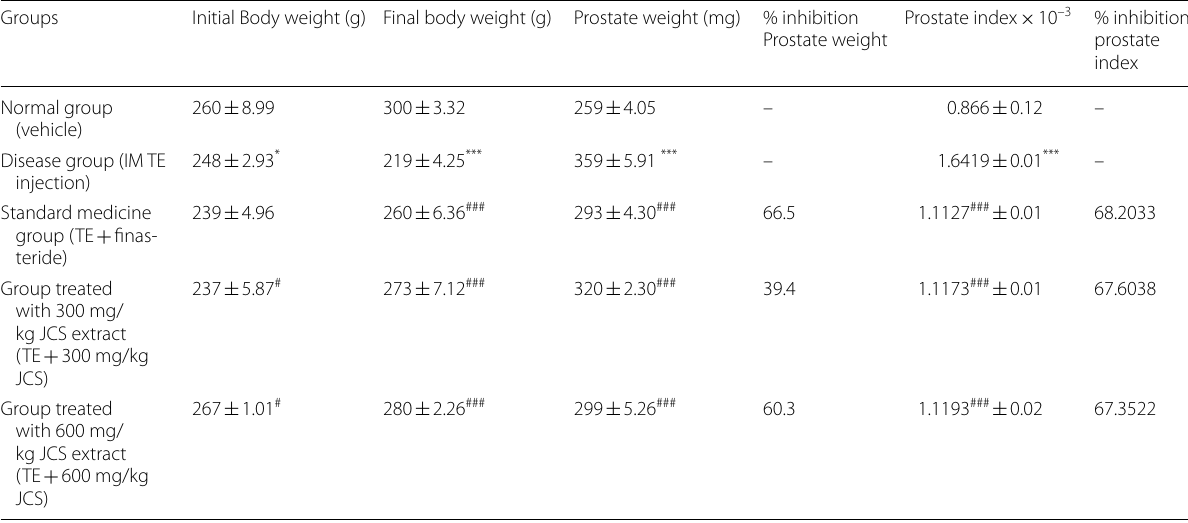
Body weight, prostate weight and prostatic index in the examination groups were as follows: normal group (vehicle), disease group, standard medicine group, groups treated with 300 mg/kg and 600 mg/kg JCS extract for 28 days TE testosterone enanthate, JCS Juniperus communis The values are expressed as Mean SEM (N 6 animals /group). *** p < 0.001, ** p < 0.01, * p < 0.05 vs Control, ### p < 0.001, ## p < 0.01 and # p < 0.05 vs TE group